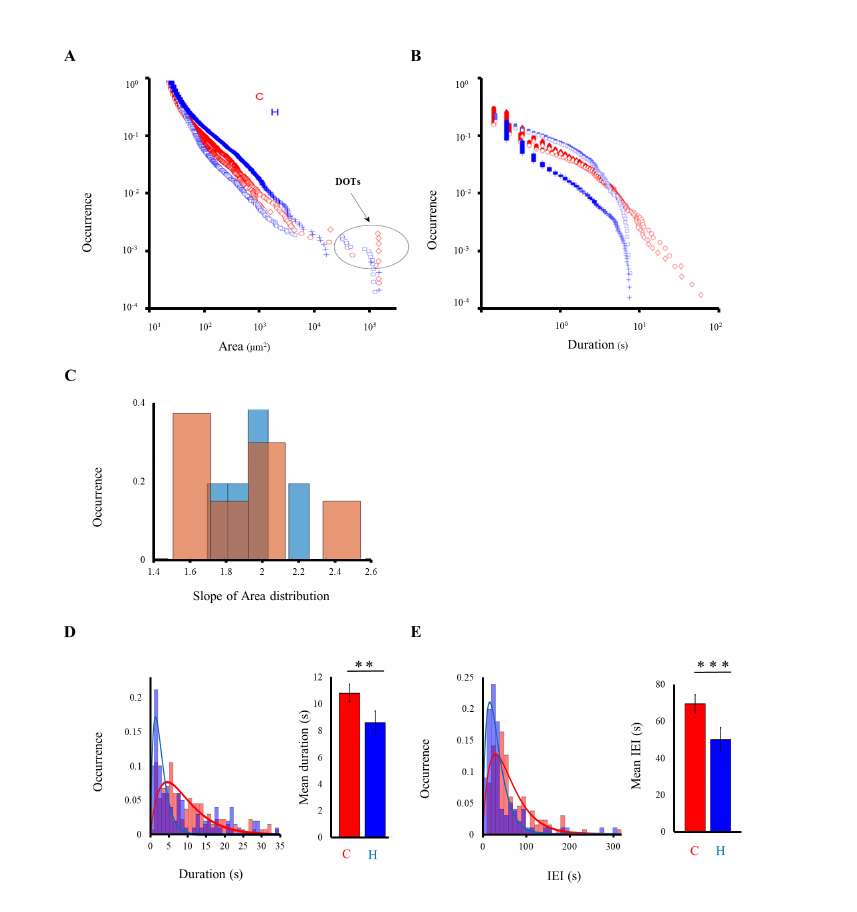
Fig. 4. Dynamics of cortical and hippocampal events compared. (A, B) Power law distributions of area and duration of COTs from four representative experiments with cortical events (C) marked in red, and hippocampal events (H) marked in blue. DOTs are represented as outliers outside the area’s distributions (see black circle in A). The area distributions are power laws (power law hypothesis test p > 0.1) and display a slope close to 2. (C) Distribution of power law slopes for area in the cortex (red bars) and hippocampus (blue bars); n = 16 cortical recordings, n = 8 hippocampal recordings. (D) Distribution (left panel) and average values (right panel) of cortical (red bars) and hippocampal (blue bars) DOTs durations. The corresponding exponential fitting is f(x) = 0.05*x*exp(-x/4.54) for the cortex, f(x) = 0.33*x*exp(-x/1.39) for the hippocampus. (E) Distribution (left panel) and average values (right panel) of Inter Event Intervals (IEIs) in cortical (red bars) and hippocampal (blue bars) slices. The corresponding exponential fitting is f(x) = 0.011*x*exp(-x/33) for the cortex, f(x)=0.034*x*exp(-x/17)+0.58 for the hippocampus. n = 102/7 cortical DOTs/slices, n = 137/7 hippocampal DOTs/slices analyzed. ⃰ ⃰ p < 0.01, ⃰ ⃰ ⃰p < 0.001 Kruskal-Wallis